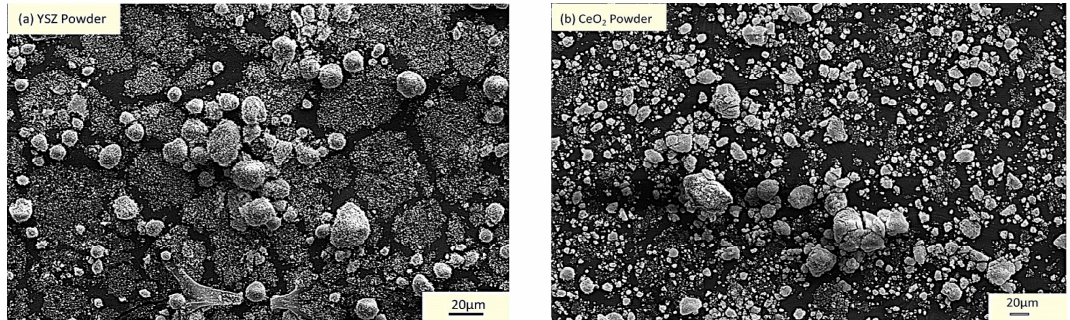
Figure 1. Scanning electron microscope (SEM) images of as received ( a ) yttria stabilized zirconia (YSZ) and ( b ) CeO 2 powders.